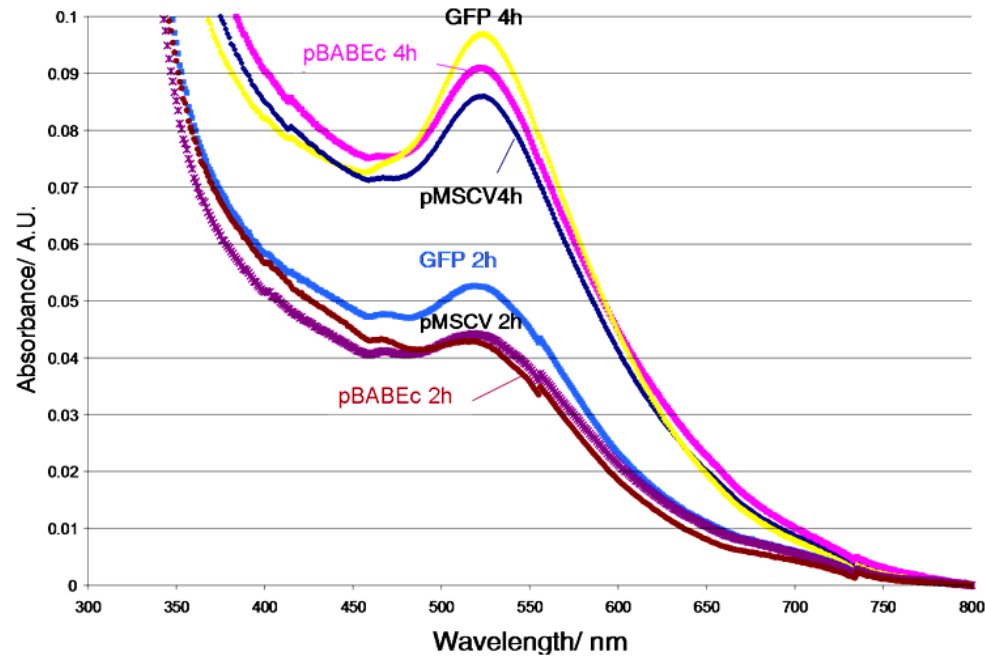
Figure 7. UV-visible spectra of three different plasmid DNA samples incubated in the dark at 70 °C for 2 and 4 h. The λ and half-width of the peaks indicate that these plasmids max yield Au NPs with similar size and distribution. The spikes at ~550 nm and ~740 nm are instrumental